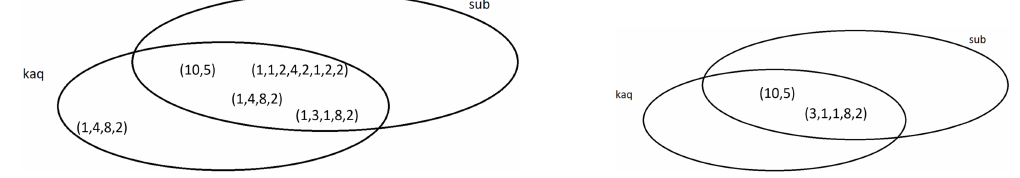
Figure 2 . su (4) : Of the 13 kaq instances with pattern (1 , 4 , 8 , 2) , ten of them are not sub . The other three are sub by the combination of the 2 D + 1 D eigenspaces forming a 3 D Lie subalgebra ( su (2) ). The same is true for (1 , 1 , 2 , 4 , 2 , 1 , 2 , 2) where the second 1 D along with the next 2 D form an su (2) . The 10 D eigenspace in (10 , 5) also gives a Lie subalgebra (likely isomorphic to sp (2) as observed in [1]).